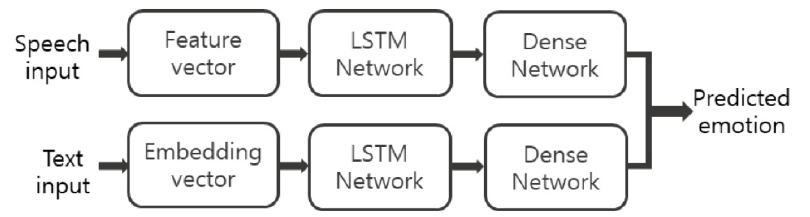
Figure 5. The architecture of the proposed